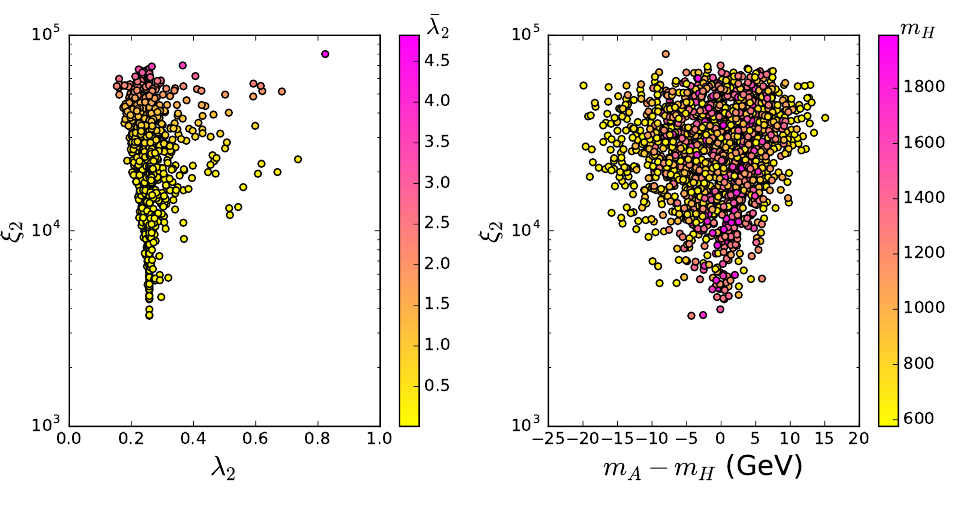
Figure 9 . In the type-II model, scatter plots of ξ 2 and λ 2 satisfying the constraints of pre-inflation, h 2 -inflation, the exclusion limits from searches for Higgs at LEP, the flavor observables, R b , and the direct searches at the